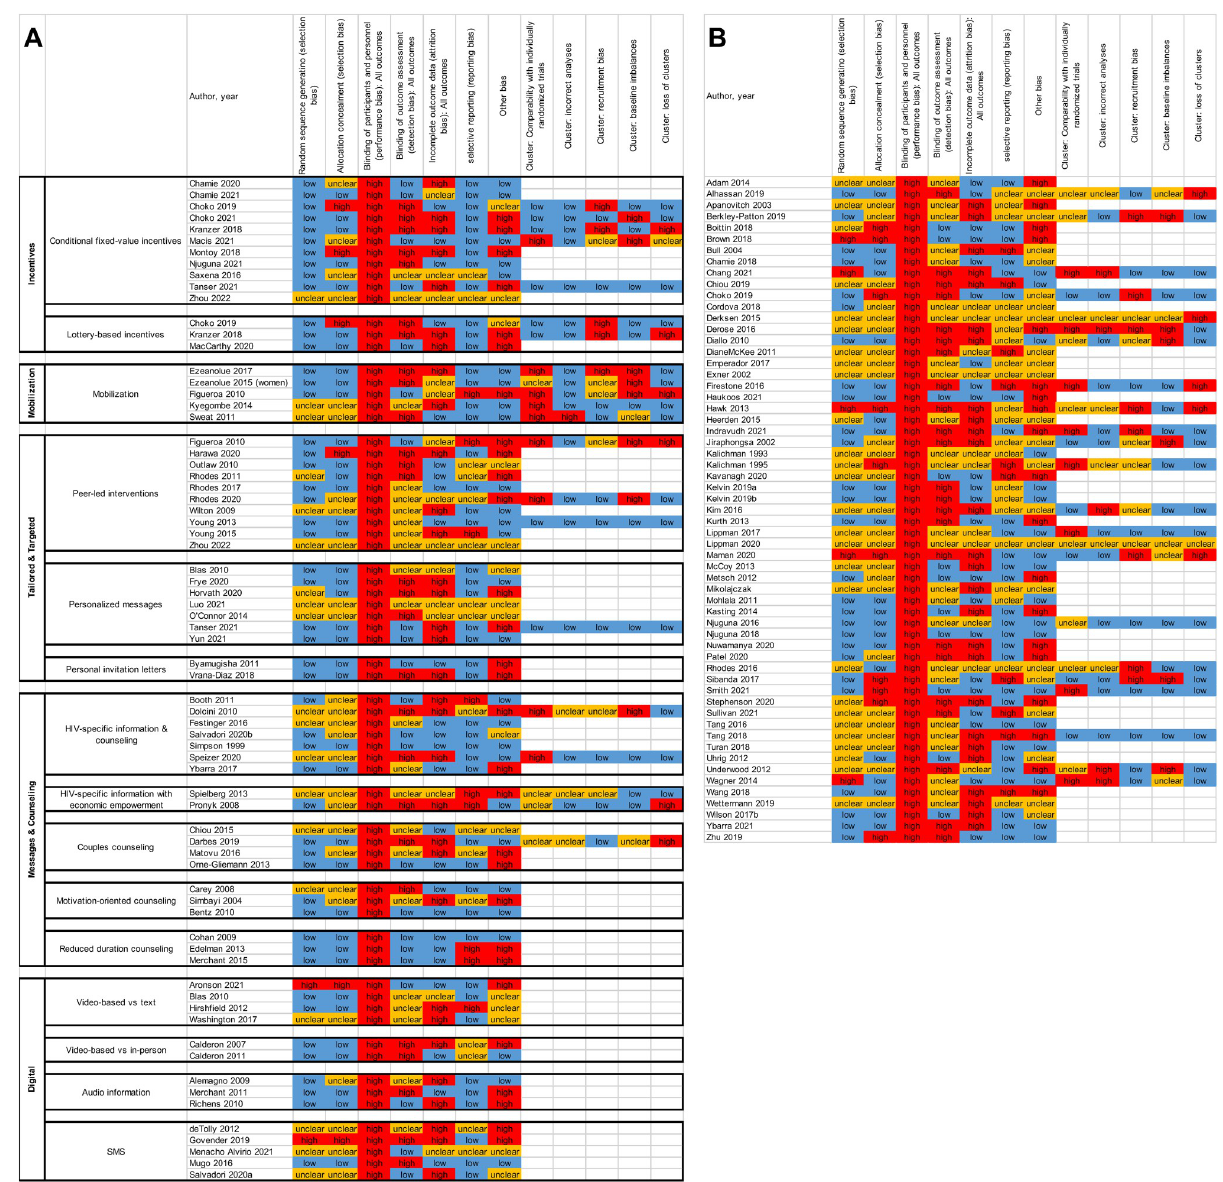
Fig 2. (A and B) Risk of bias summary. Panel (A): Pooled studies. Studies are grouped by the meta-analysis that they contributed to. Panel (B): Not pooled studies. Studies that were not pooled are listed in alphabetical